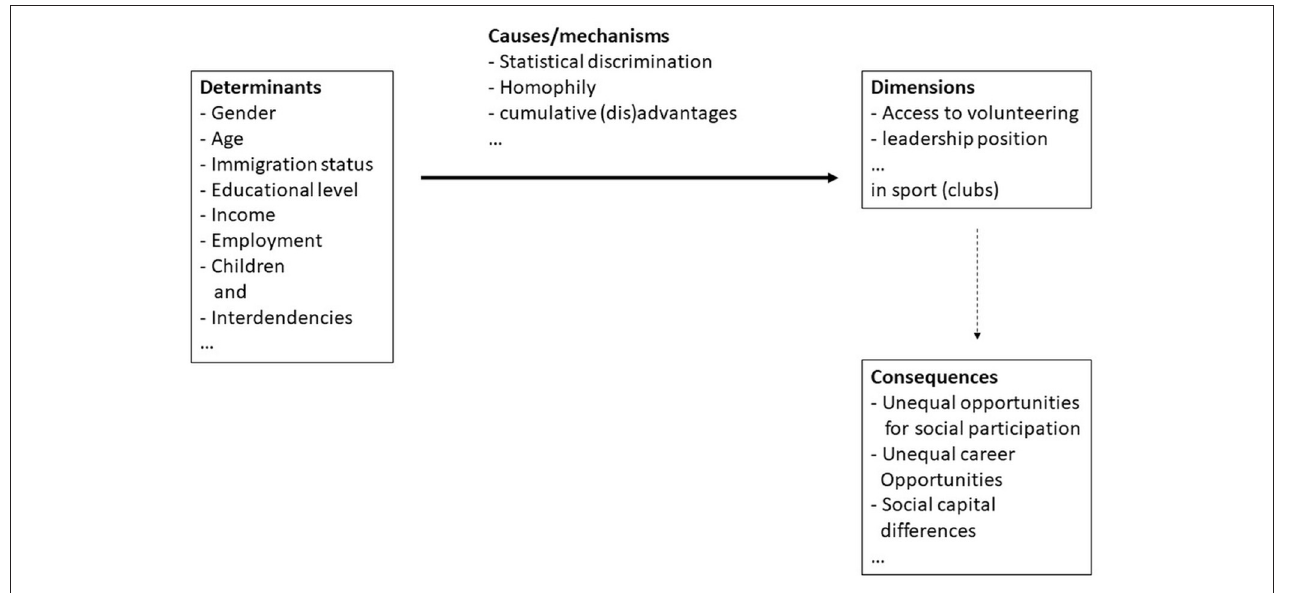
FIGURE 1 | Volunteering as a dimension of social inequality (modified according to Solga et al., 2009, p. 17 and Rameder, 2015, p.